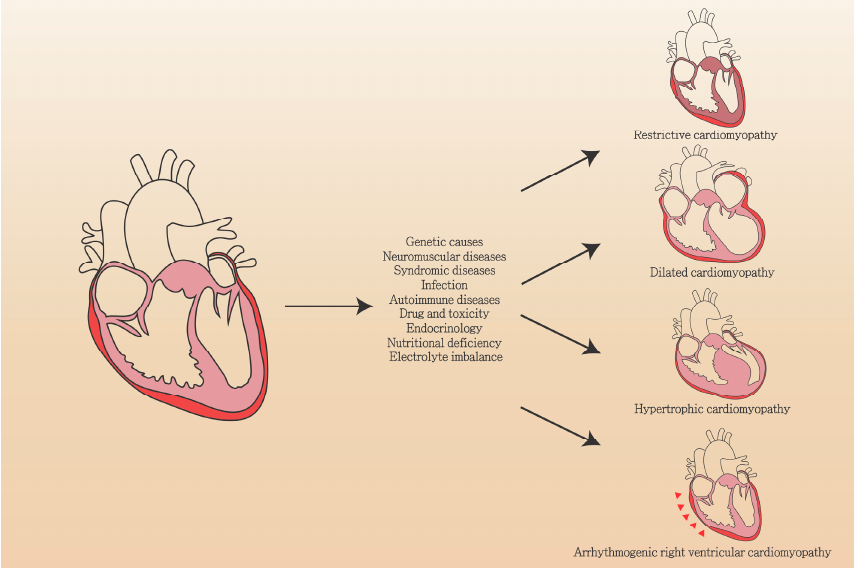
Figure 1. Risk factors of the four major types of cardiomyopathy.